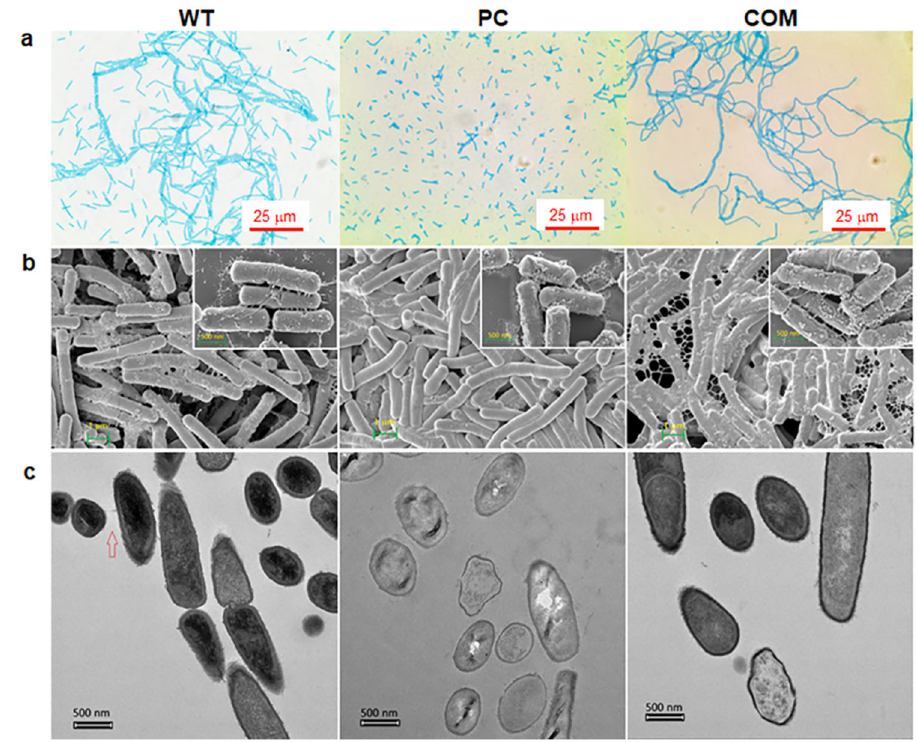
Fig. 3 Morphologies of wild-type (WT), plasmid-cured (PC), and complemented (COM) cells of strain GH1-13. a Microscopic images (1000-fold magni fi cation) of WT, PC, and COM cells stained with Alcian blue for polysaccharide and Safranin O for cellular DNA. b Scanning electron microscopy (AURIGA) images of platinum-coated WT, PC, and COM cells at 20,000-fold magni fi cation and 70,000-fold magni fi cation (insets). c Bio-transmission electron microscopy images (Talos L120C, 120 kV) of the dissected WT, PC, and COM cells. The cells were treated with 10 mg/L potassium tellurite for 1 h during cultivation in tryptic soy broth at 25 °C with shaking (180 rpm). The head of the arrow shows a pilus-like structure that connects cells across the